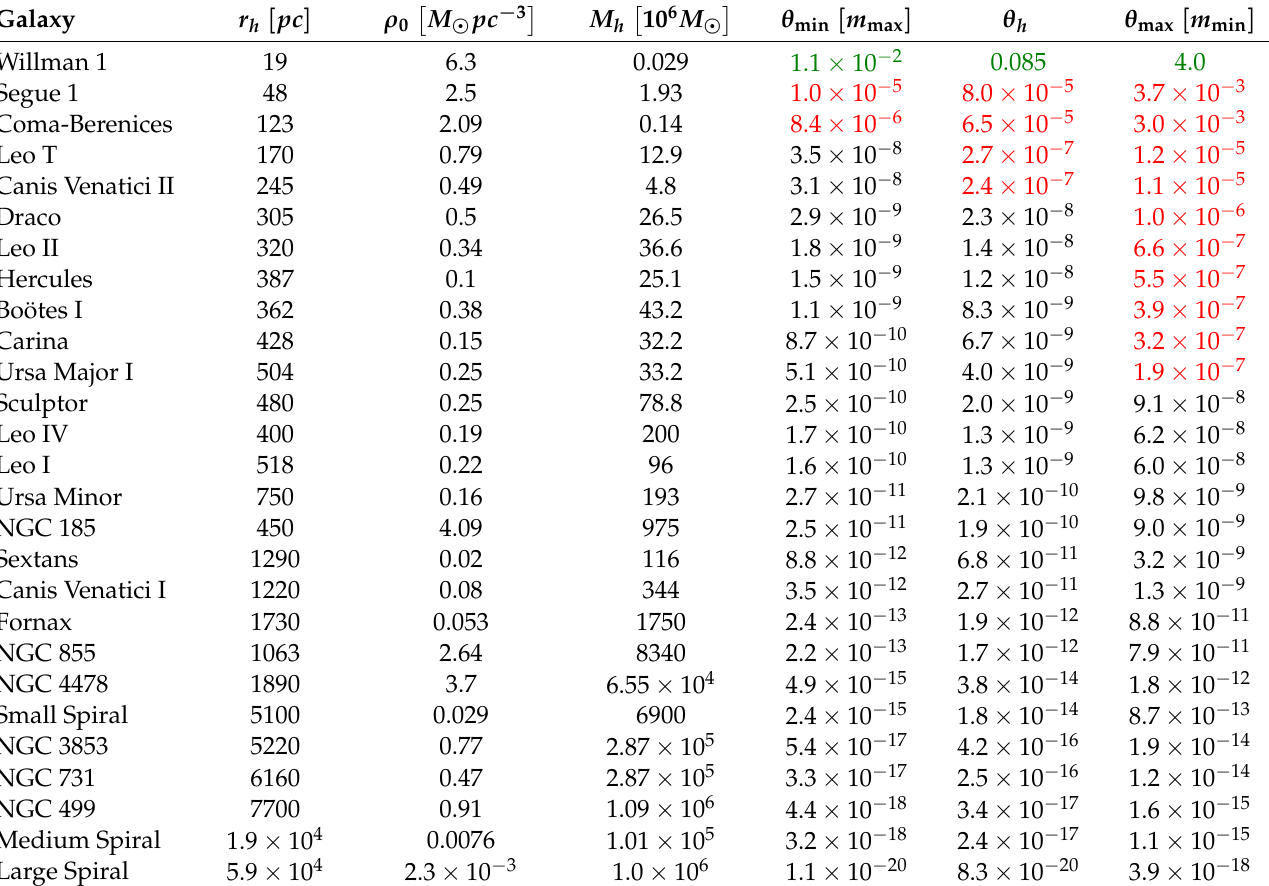
Table 1. Observed values of the DM halos parameters [ r h (radius), ρ 0 (central density) and M h (mass)] employed by Destric and co-workers covering from ultracompact galaxies to large spiral galaxies (obtained from [53–62]). Assuming that the dwarf galaxy Willman 1 belongs to the region III of fermionic King model, θ 2 ≤ θ ≤ θ m , the mass m of WDM particles should belong to the range m min = 1.2 keV ≤ m ≤ m max = 2.6 keV. For this range of values, it was calculated the mass ratio θ = M F / M for the rest of galaxies. Here, θ f is the pre-factor of Equation (36), which corresponds to the mass ratio for a WDM particle with mass m = 2 keV, while θ max and θ min are the mass ratios corresponding to the minimum and maximum masses m min and m max , respectively. The black values of the mass ratio θ belong to region I (0 < θ < θ 1 ), the red values belong to the region II ( θ 1 < θ < θ 2 ), while the green values to the region I ( θ 2 < θ ≤ θ m